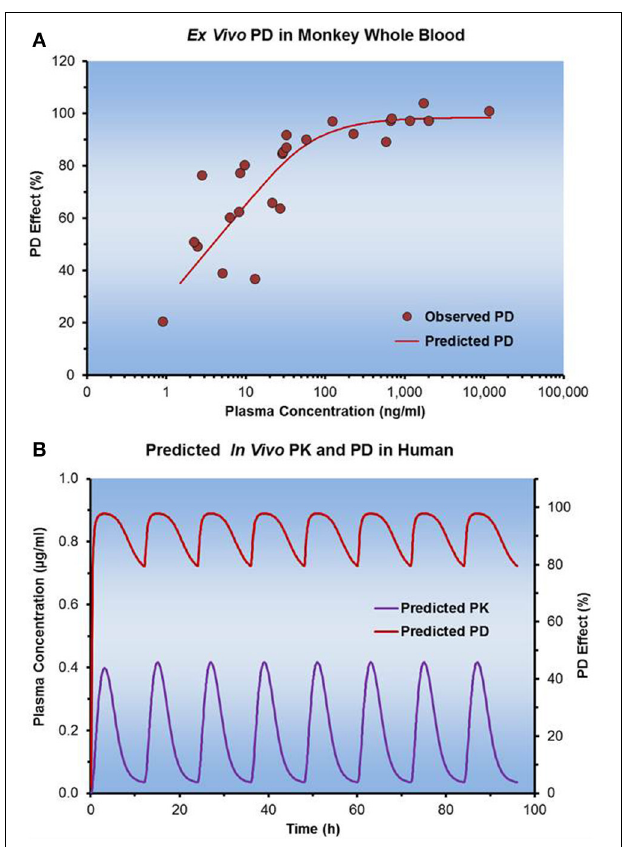
FIGURE 14 | Translation of preclinical PD data to humans. (A) Illustrates the ex vivo incubation data of a drug molecule in whole blood from Cynomolgus monkey when used to determine concentration dependent changes in the desired PD effect. (B) Shows how the model fit of PD parameters from the incubations were used to predict the in vivo efficacy. Allometric scaling of PK parameters enabled simulations of plasma concentrations in